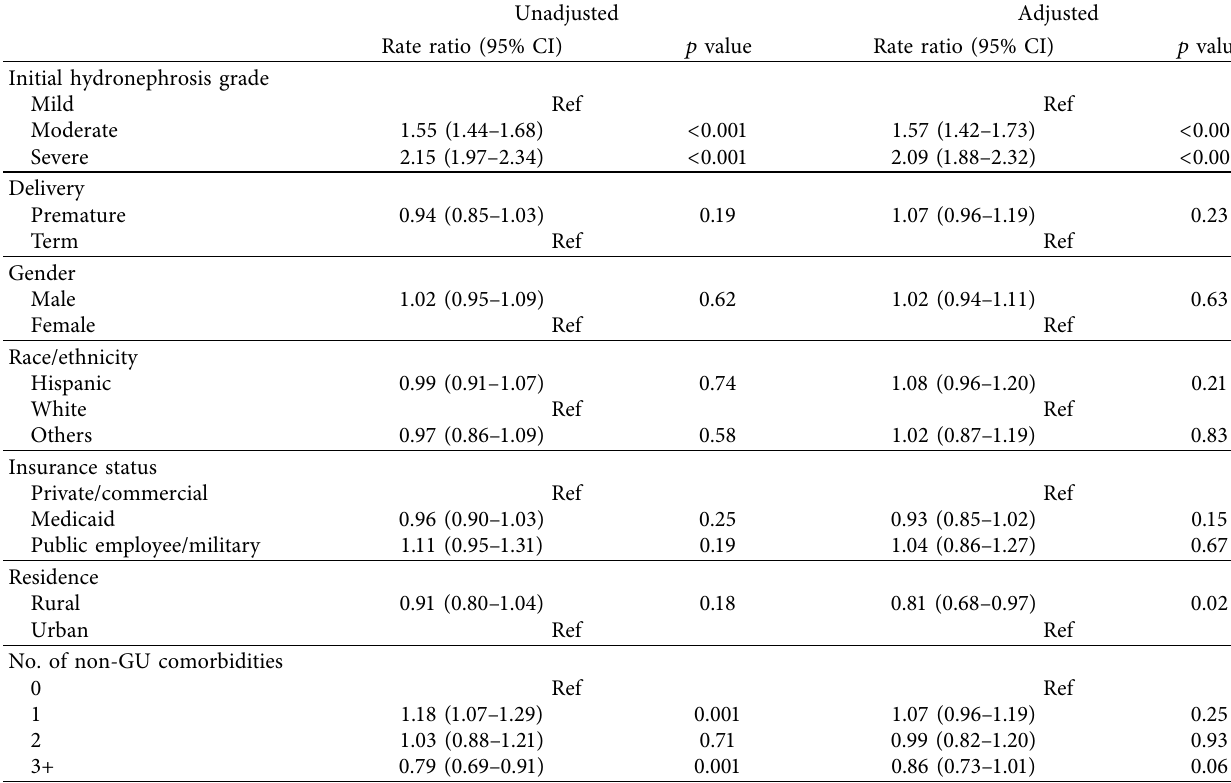
Table 2: Association between total imaging use in infancy and initial postnatal ultrasound grade of